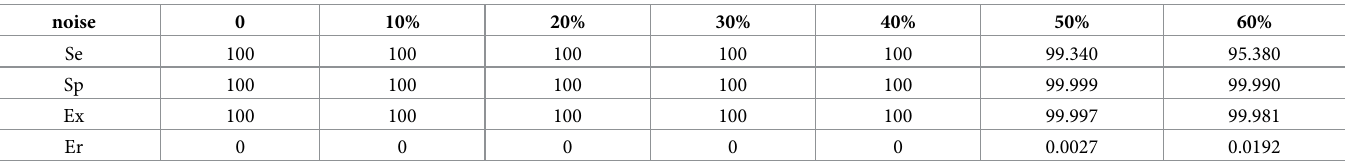
Table 4. Quadruple metrics under different mutation rates (%)– 9 × 9 coding set. noise